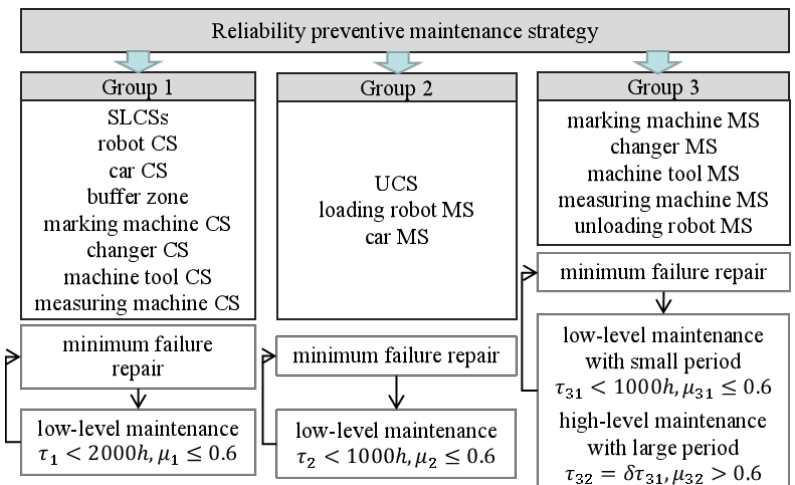
Figure 9. Preventive maintenance strategy of a FMS.